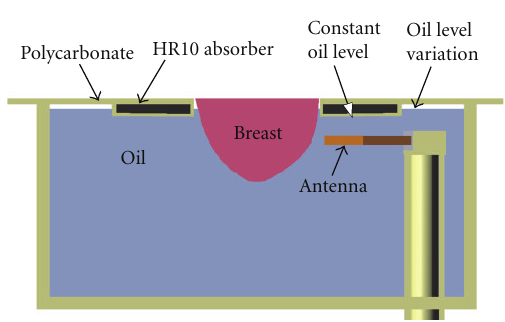
Figure 7: Profile view of the specially designed lid.